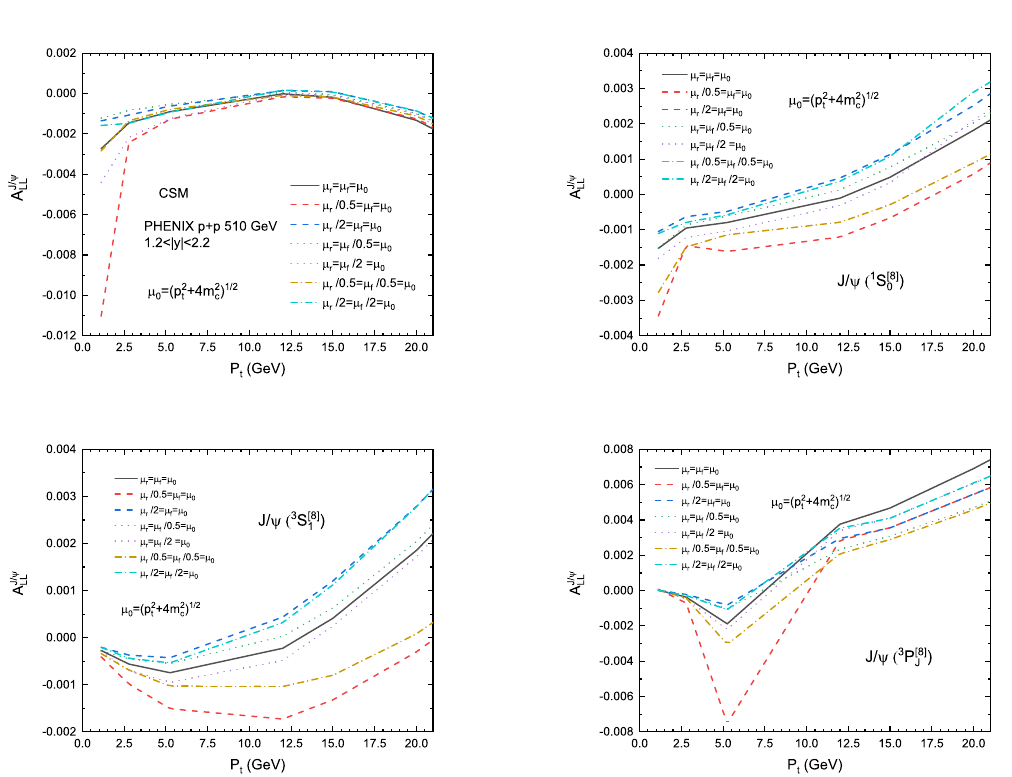
Figure 3 . The double longitudinal asymmetry A J/ψ